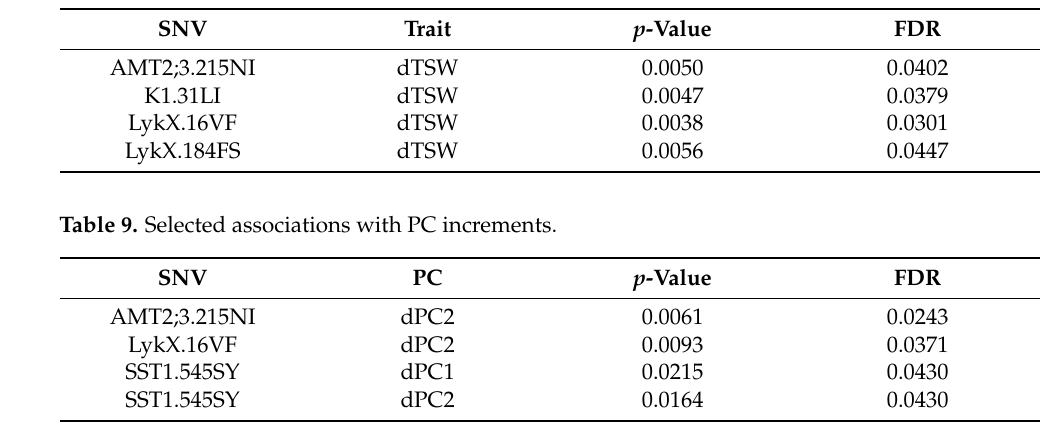
Table 8. Selected associations with trait increments.